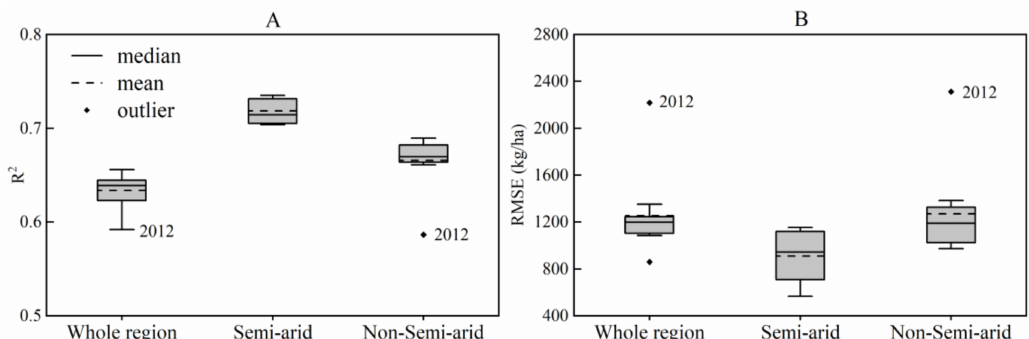
Figure 7. Boxplot of phenological yield prediction model performance for ( A ) R 2 and ( B ) RMSE in the whole region, semi-arid region, and non-semi-arid region. The models were built with the four most significant phenological metrics using leave-one-year-out cross-validation from 2008 to 2018. Table 3. Results for stepwise multiple regression between Max-R 2 with rate and duration and yield. Dates from 2008 to 2018. Region Equation R 2 VIFs Whole region Semi-arid